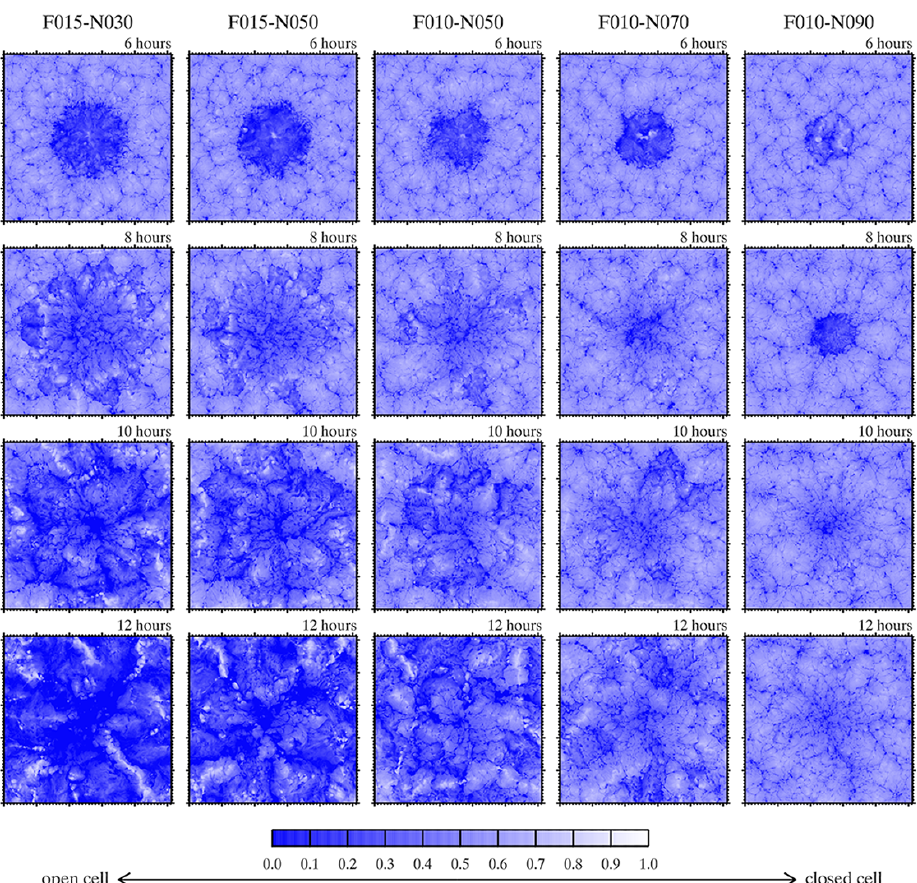
Figure 5. Time evolution of the computed albedo for selected S2 cases. Cases are placed so that the case with open cells is on the left side, the closed cell case is on the right side, and transition cases are in between. Categorization is based on the metric discussed in the